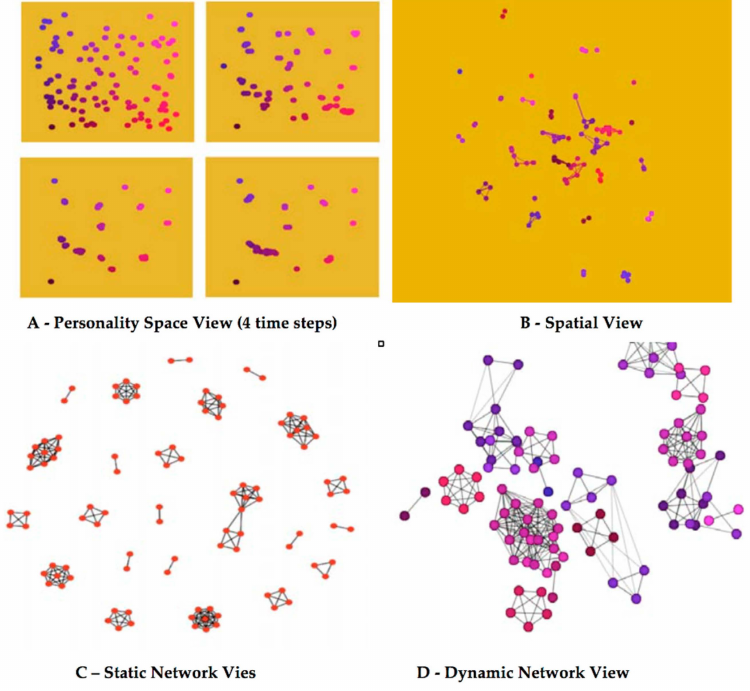
Figure 6. Four Unique Visualizations of the CliqueCreator Scenario. A to D are described in